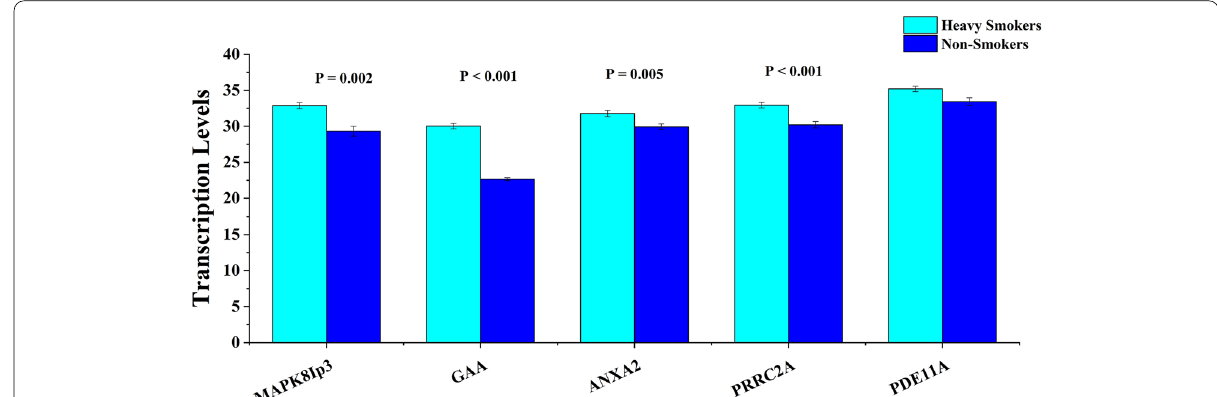
Fig. 8 Transcription level of MAPK8IP3 , GAA , ANXA2 , PRRC2A , and PDE11A genes in spermatozoa of heavy smokers compared to non-smokers. P < 0.05: significant; P